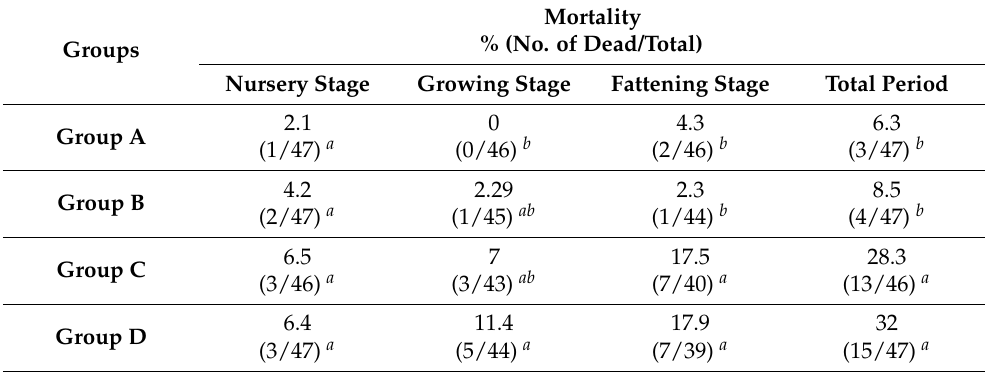
Mortality % (No. of Dead/Total)